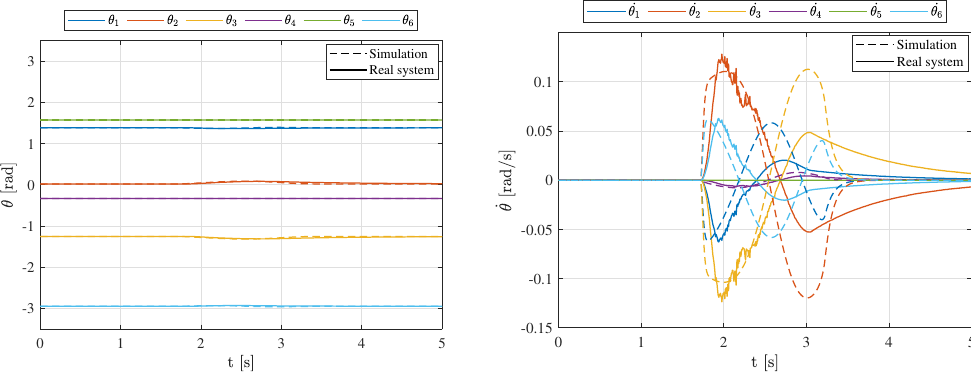
Figure 17. Test case 3, Mode III. Joint rotations ( left ) and speeds ( right ).